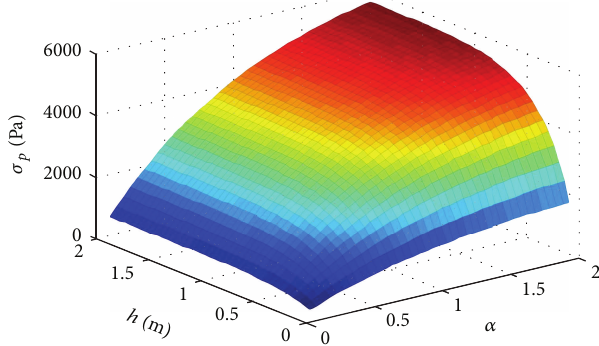
Figure 5: The variation of 𝜎 𝑝 with 𝛼 and ℎ .